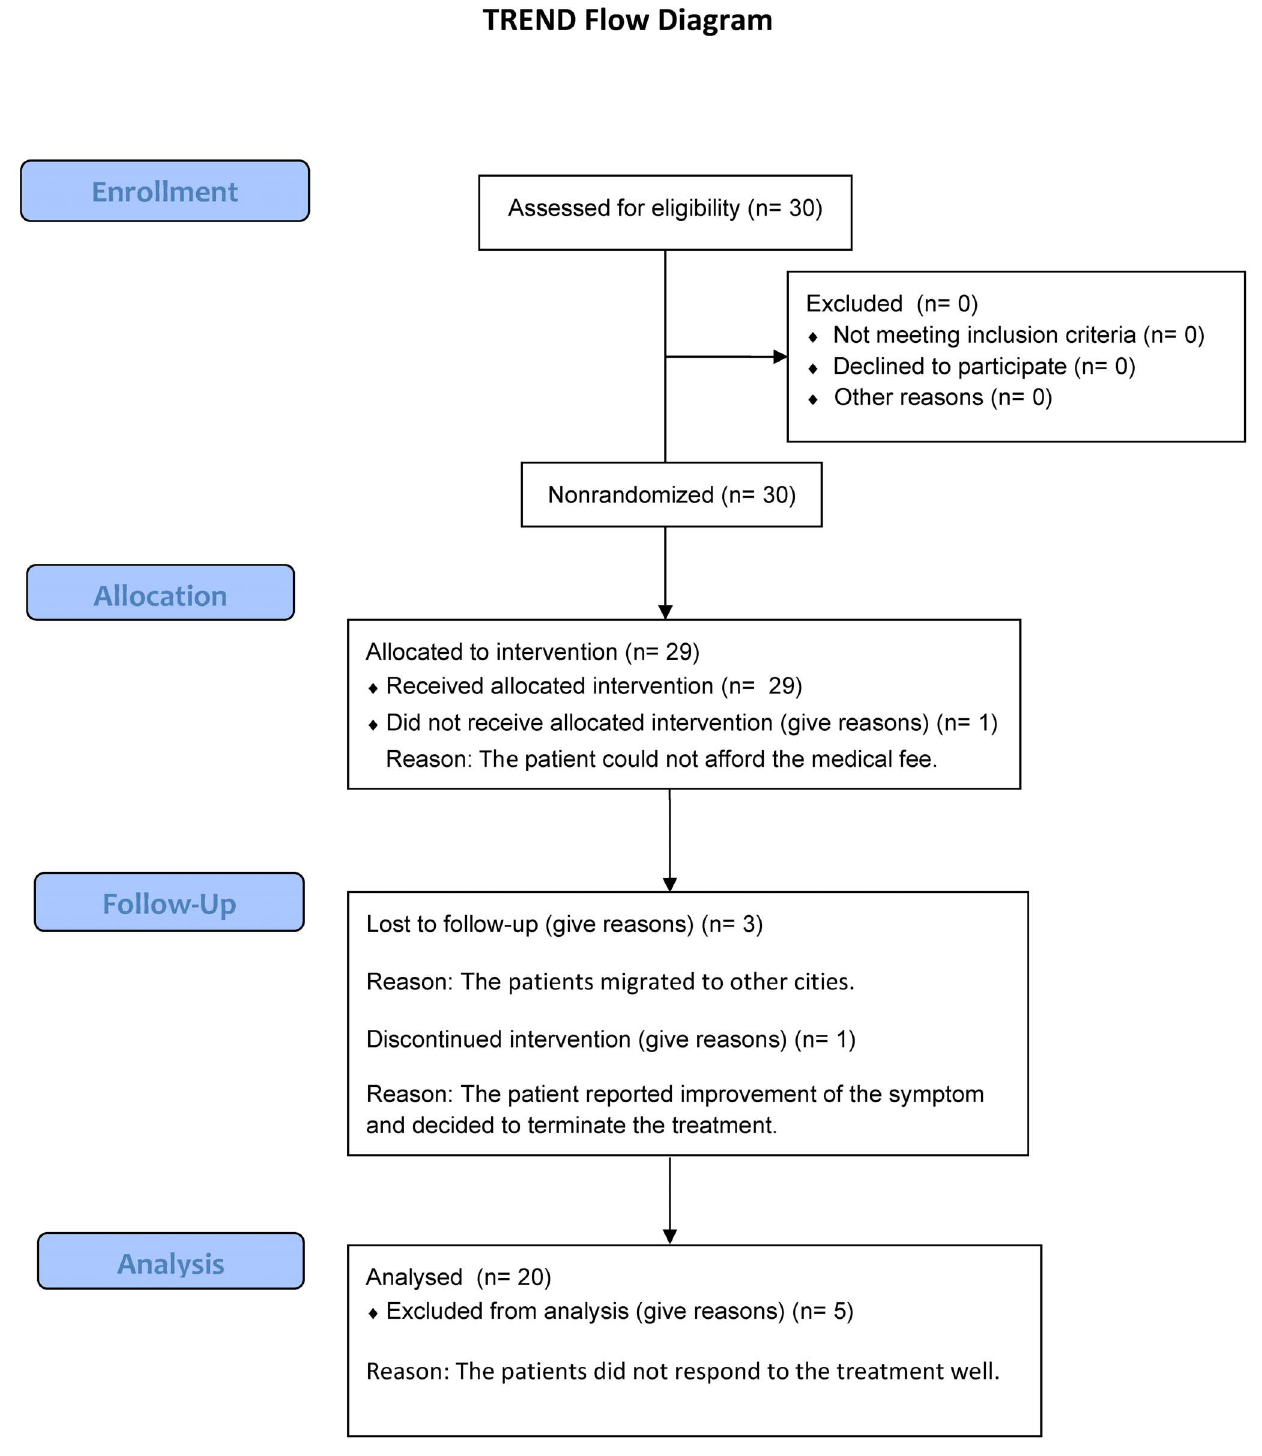
Figure 1. Flow chart of the Transparent Reporting of Evaluations with Nonrandomized Designs (TREND) shows the number of the participants through each stage of the study. doi:10.1371/journal.pone.0091950.g001 the VAS system according to the ARIA document [11]. All patients were coded confidentially and VAS was evaluated independently by a clinician in a blinded manner. The fold change of VAS value in AR patients after SIT treatment was